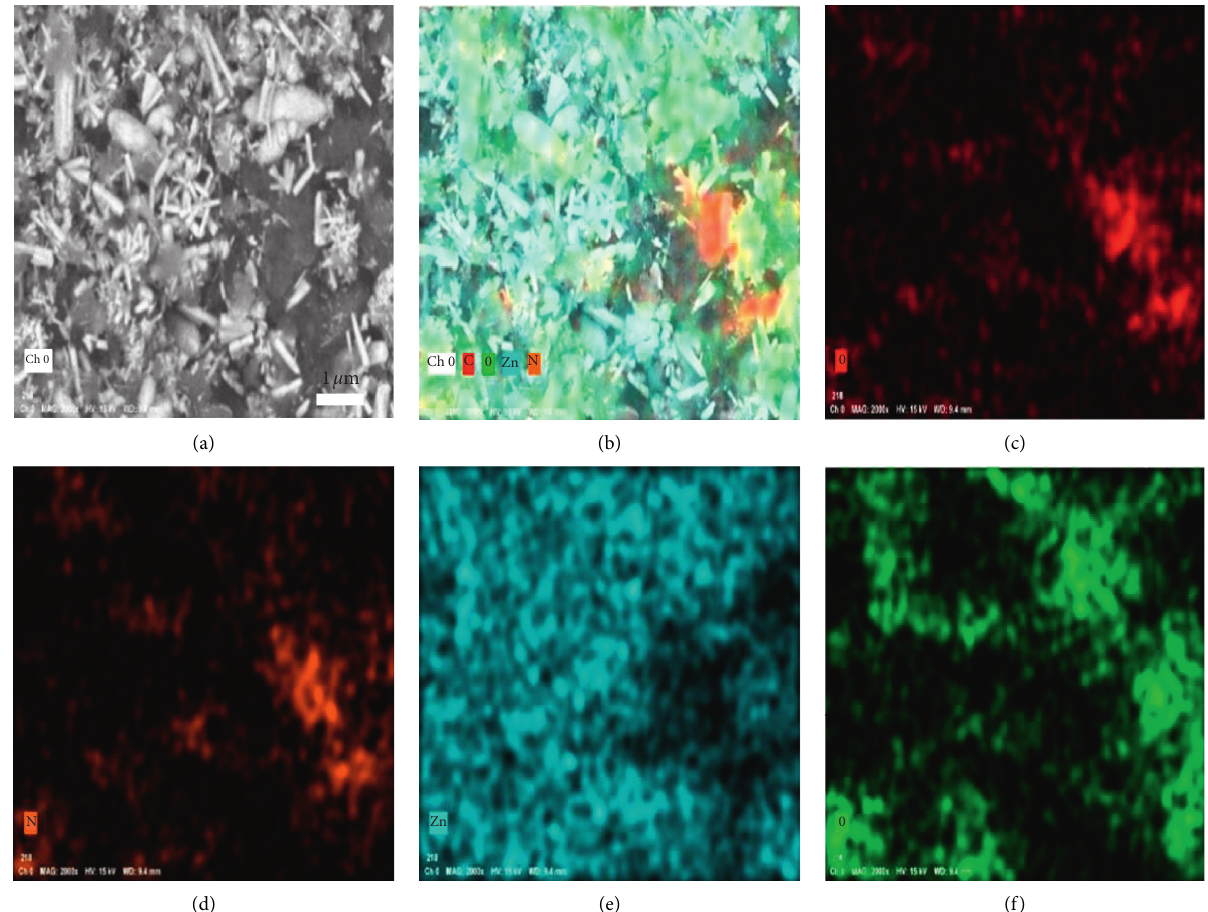
Figure 3: The EDX elemental mapping images of C, N, O, and Zn of Z-7C